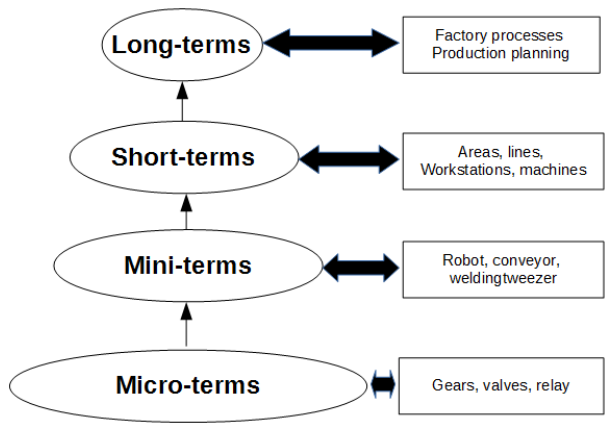
Figure 1. From the micro-term to the long-term.